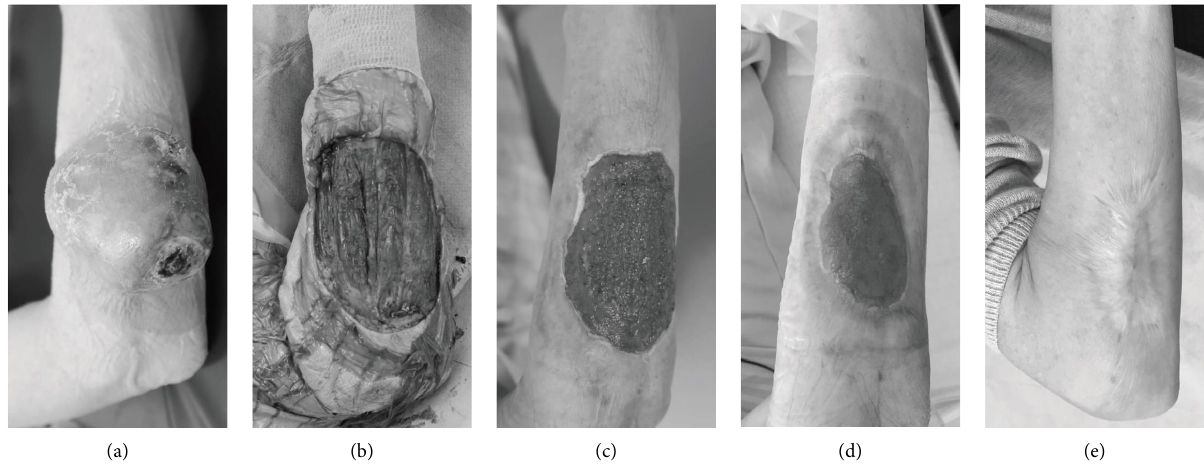
Figure 1: A 67-year-old female with an UPS on the right proximal forearm (case no. 16) (a). Te cutaneous defect is 7 × 6 cm after tumor excision (b). Te defect is covered with the granulation tissue after 4 weeks (c). Te size of skin defect has reduced with the epithelialization after 8 weeks (d). Te wound is completely healed after 6months and shows full range of motion after 20 months